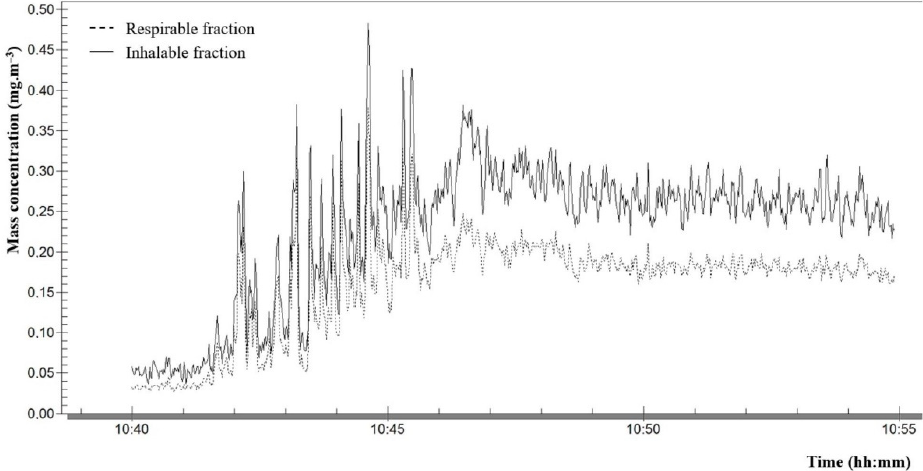
Figure 4. Temporal variations in the mass concentration of inhalable/respirable dust while cross- cutting spruce wood with a full chisel chain. Cross-cutting started at 10:41 and ended at 10:46.